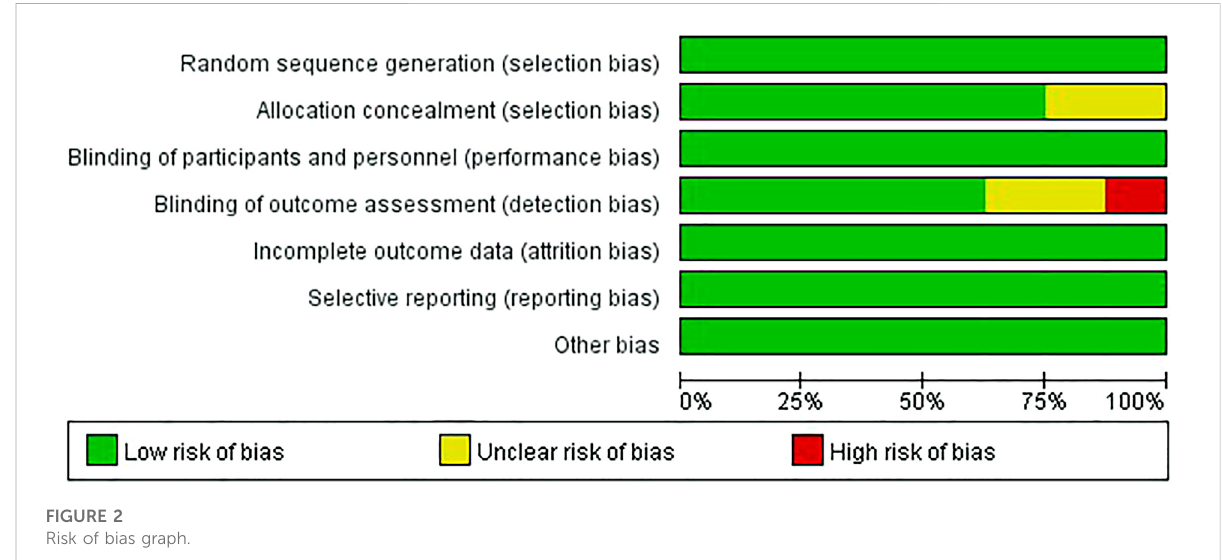
FIGURE 2 Risk of bias graph.